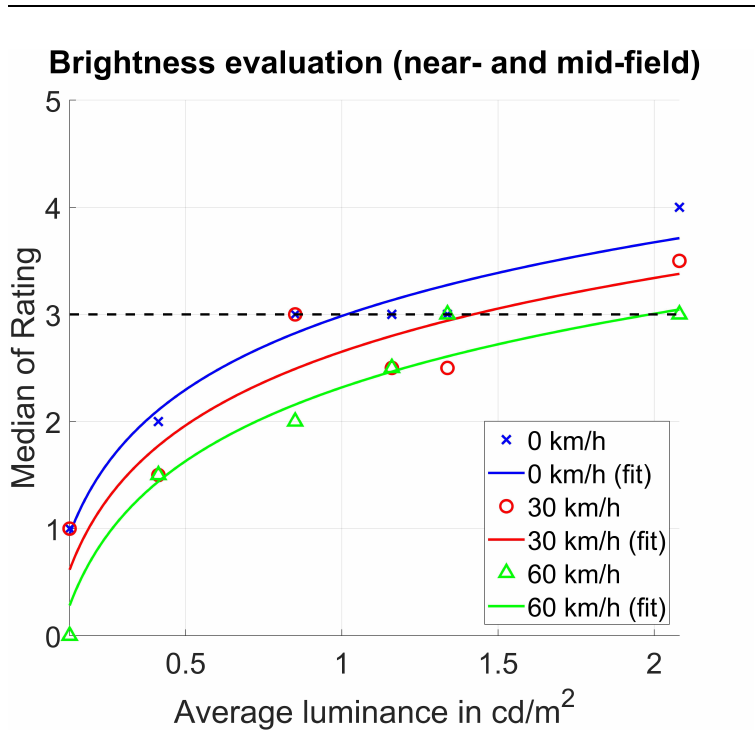
Figure 7. Dependence of the brightness evaluation on the average road surface luminance for different driving speeds (0, 30 and 60kmh − 1 ). With increasing roadway luminance, the median brightness rating increases logarithmically; with increasing speed, the same roadway luminance values are perceived darker. Dashed line represents the lower feeling of safety threshold to perform a nighttime driving task as defined in Section